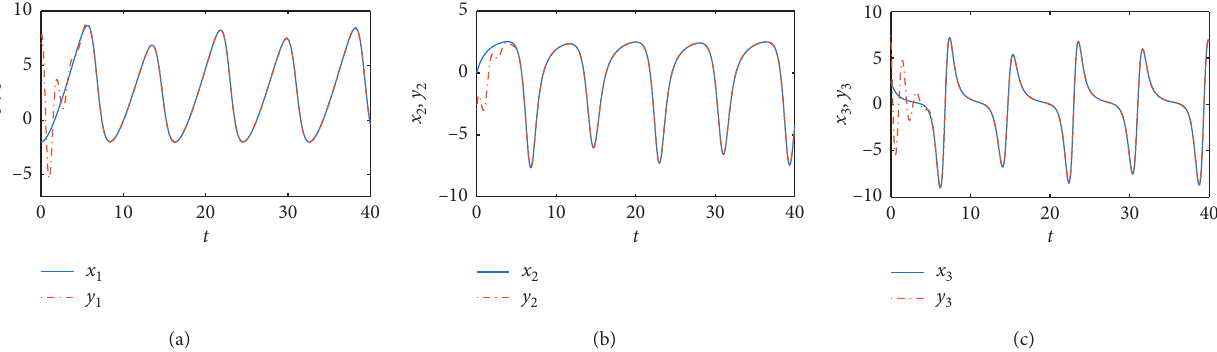
Figure 10: 3D jerk master-slave system synchronous orbits. (a) Synchronization of x of x 3 , y 3 .